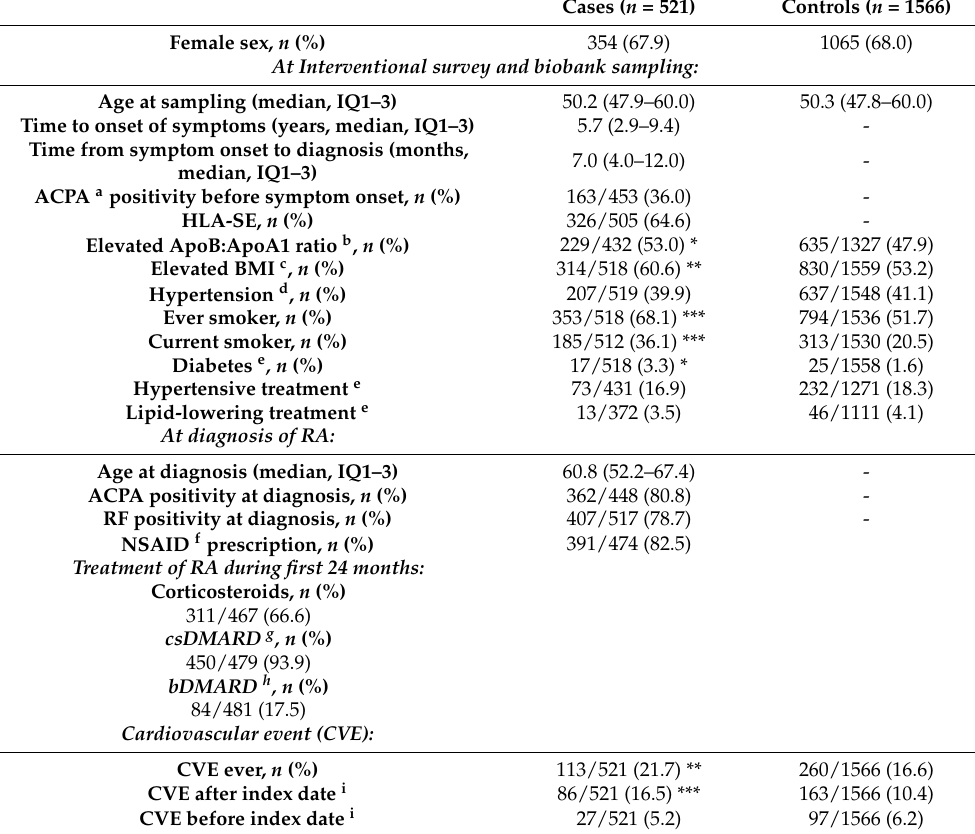
Table 1. Descriptive information on pre-RA cases and control individuals identified from the inter- ventional